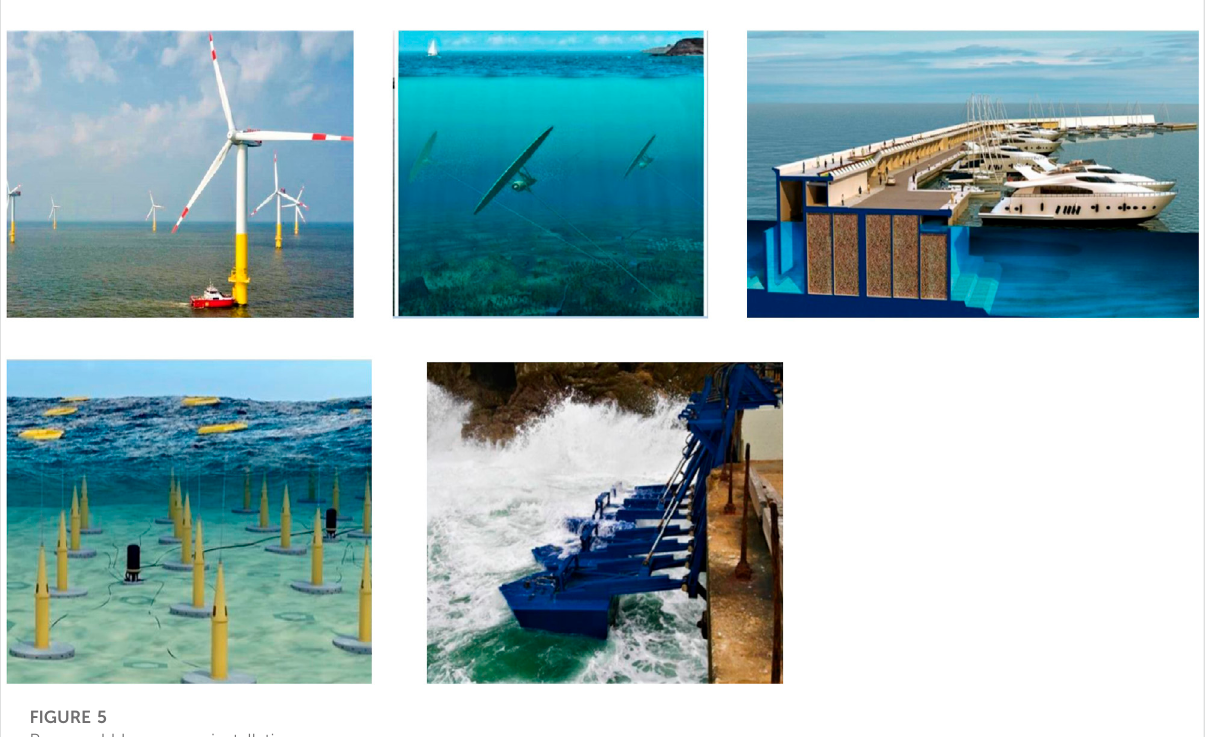
FIGURE 5 Proposed blue energy